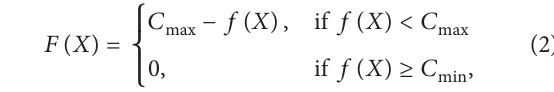
Figure 3: The choice diagram based on regulatory sample space.